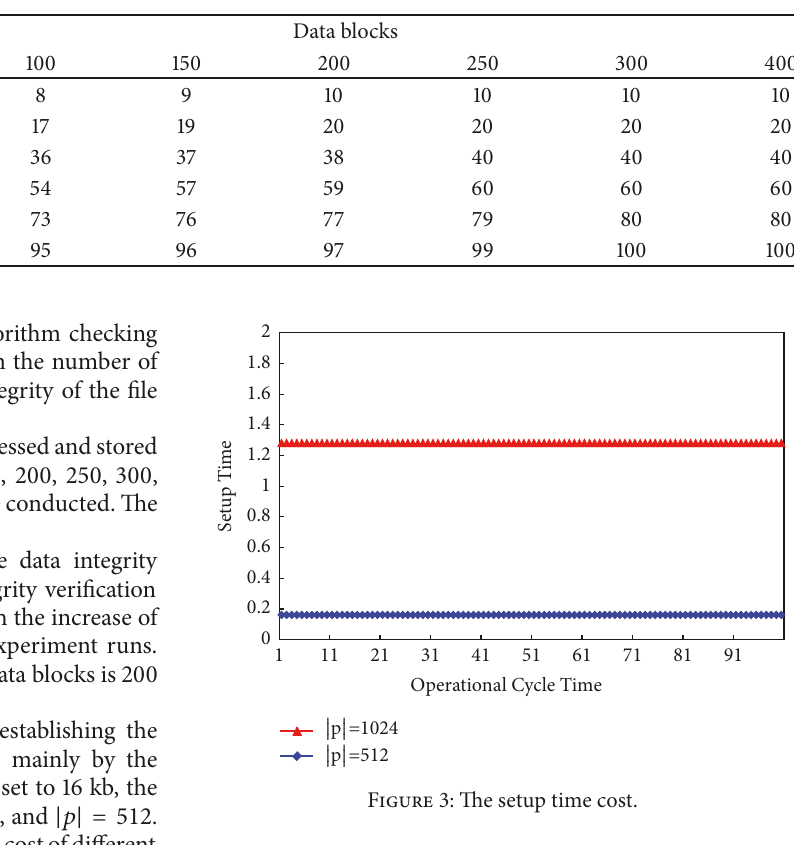
Table 4: Relationship between data block and efficiency of algorithm.